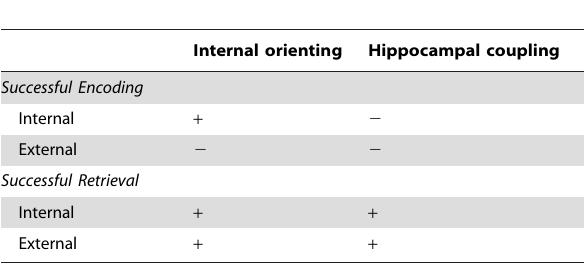
Table 1. Predictions of the two accounts regarding DMN activity during successful encoding and